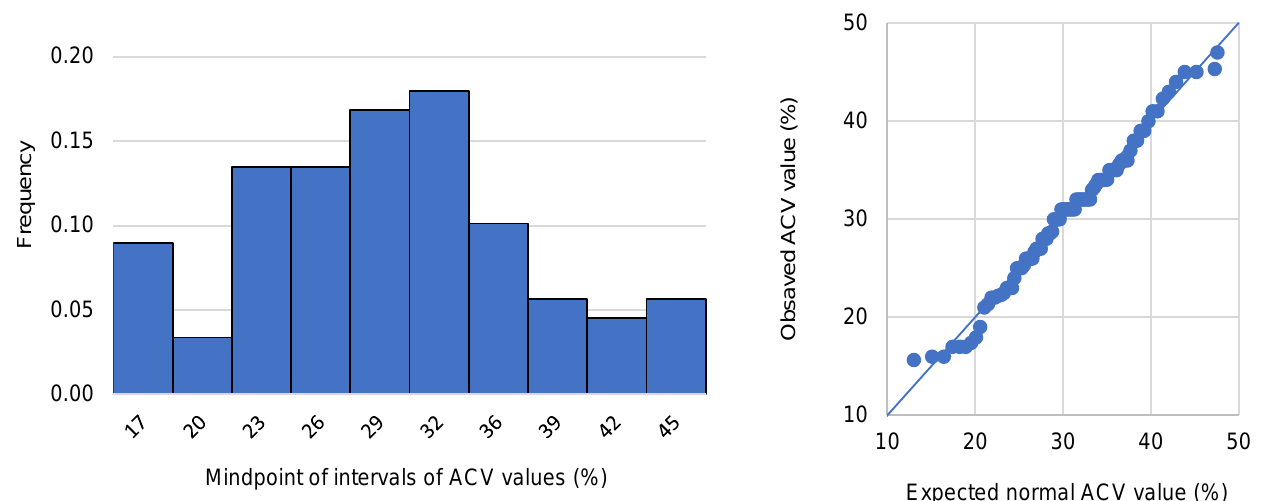
Figure 1. Histograms and normal plots of the properties studied of the RA samples.